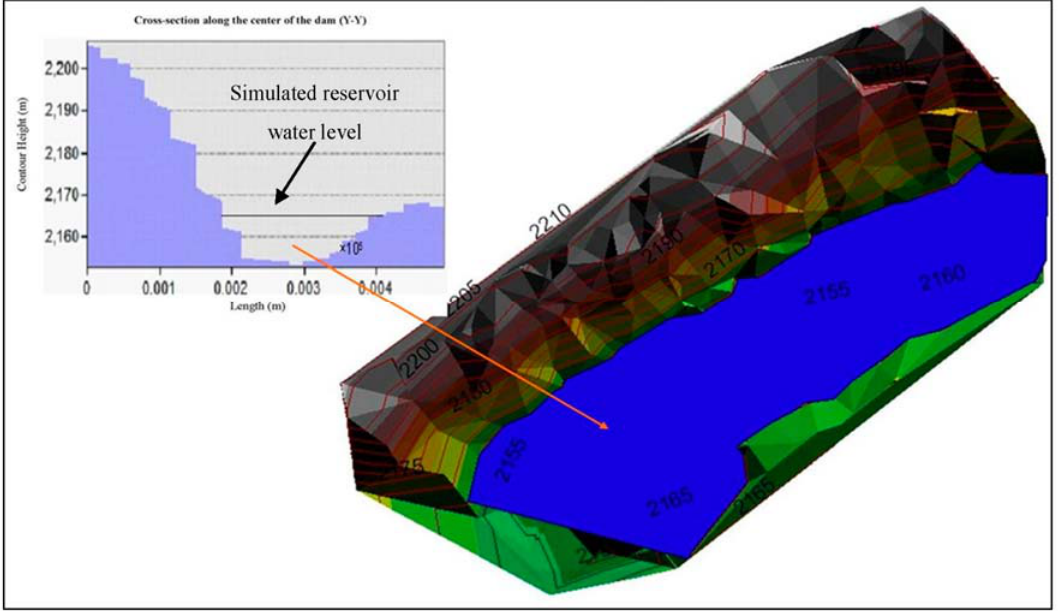
Figure 15. 3D-simulated reservoir water level at contour height of 2165 m depicting the maximum possible water level in the proposed reservoir overlaid on the 3 m × 3 m TIN.